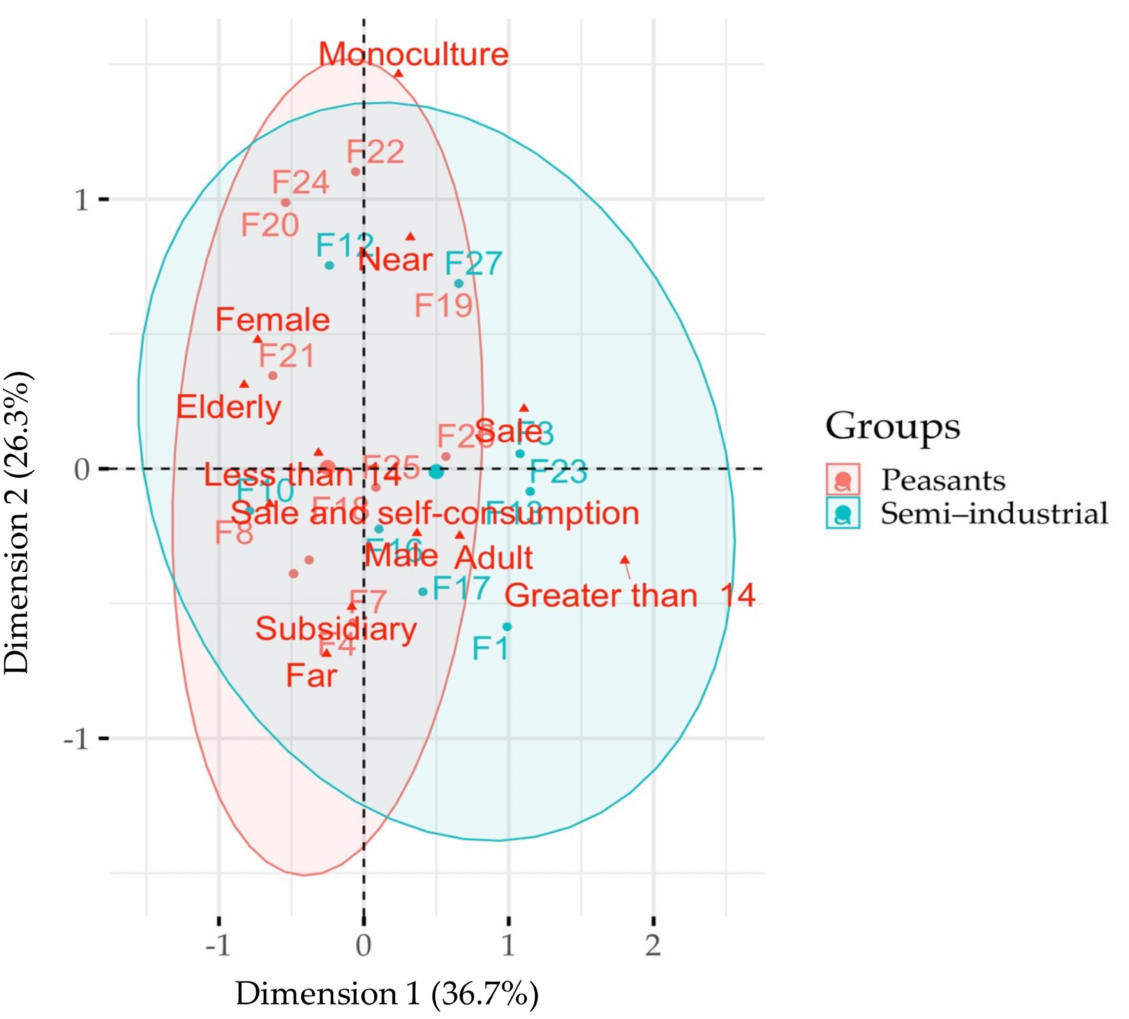
Figure 4. Multiple correspondence analysis of farmers’ and farms’